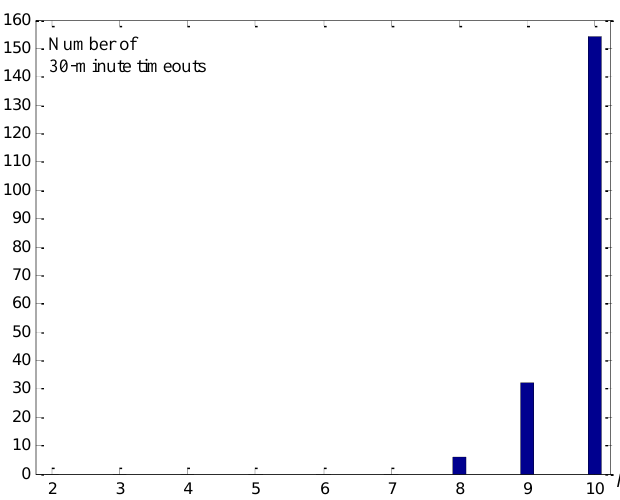
Fig. 2. The number of 30-minute timeouts distributed among 3600 generated instances. Despite the huge number of timeouts at 10 jobs, it is 38.5 % of the generated instances (154 of 400), so it does not break the statistical validity.